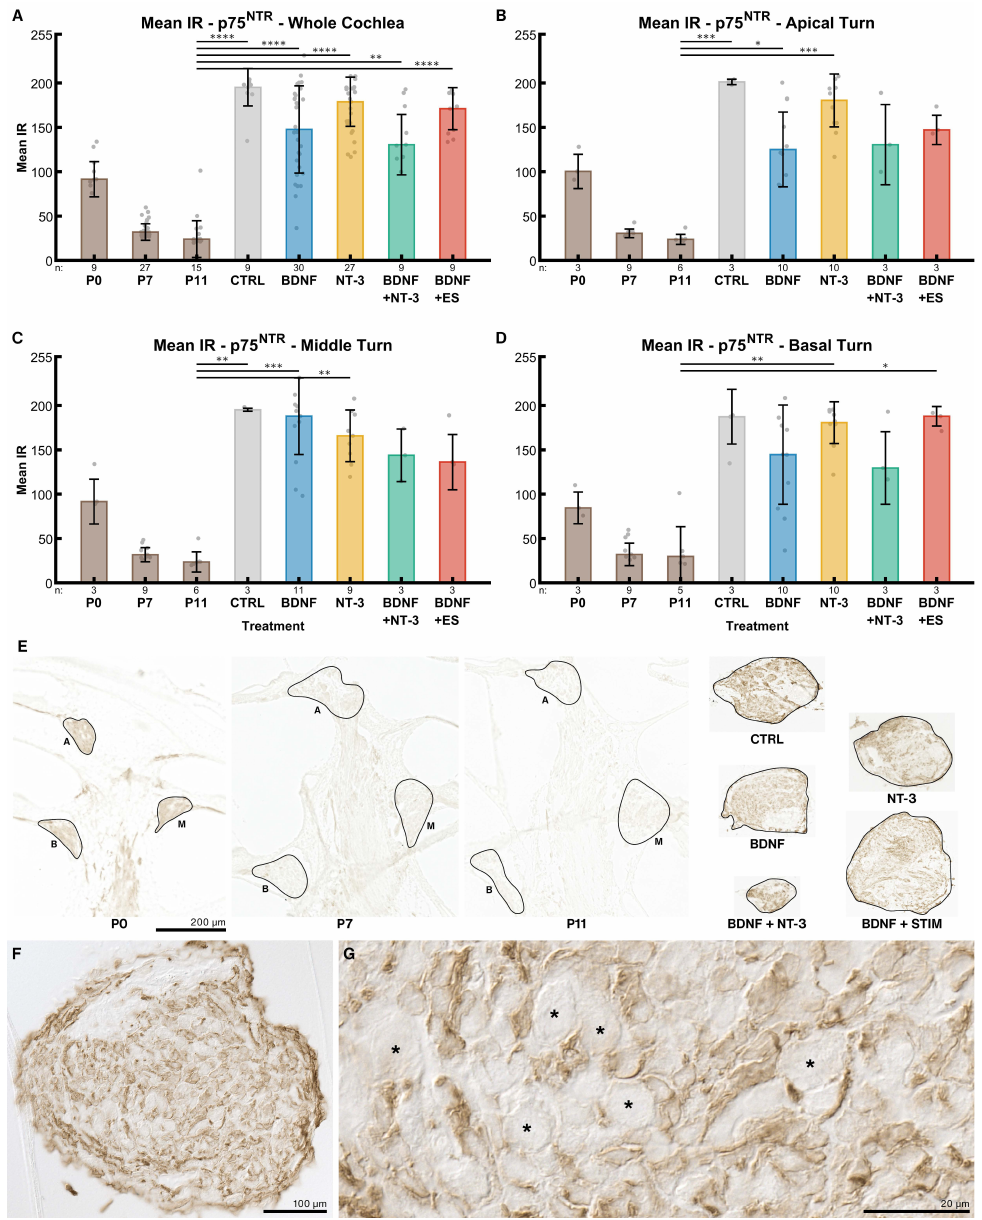
Figure 8. p75 NTR receptor expression. The diagrams ( A – D ) show the mean IRs of DAB-positive areas of histological sections at different age groups (P0–P11) and explant sections after different treatments (untreated (NT CTRL), 25 ng/mL BDNF, 200 ng/mL NT-3, 25 ng/mL BDNF + 200 ng/mL NT-3 and 25 ng/mL BDNF + 500 µ A). The groups in the first graph ( A ) contain an equal number of samples from three turns, hence representing the whole cochlea. Diagrams ( B – D ) depict the individual turns. ( A – D ) The whiskers denote the standard deviation. Individual samples are marked as grey dots. The number of samples in each group is written right below the X-axis. The asterisks or ns (not significant) above the groups indicate the significance level of a Kruskal–Wallis test followed by a Dunn’s multi- comparison post-hoc test. The DAB intensities of P0–P11 pups were tested among themselves, and the treated explants were compared with the control and the P11 group. Non-significant differences are not shown. ( E ) Representative sections closest to the median mean IR of the groups in ( A ). The solid black lines mark the regions of interest. A, M and B denote apical, middle, and basal turns, respectively. The explant sections are all from the middle turn. ( F ) Overview and detail ( G ) of a 25 ng/mL BDNF-treated explant. SGNs are marked with an asterisk and do not exhibit any IR, while surrounding cells are considerably